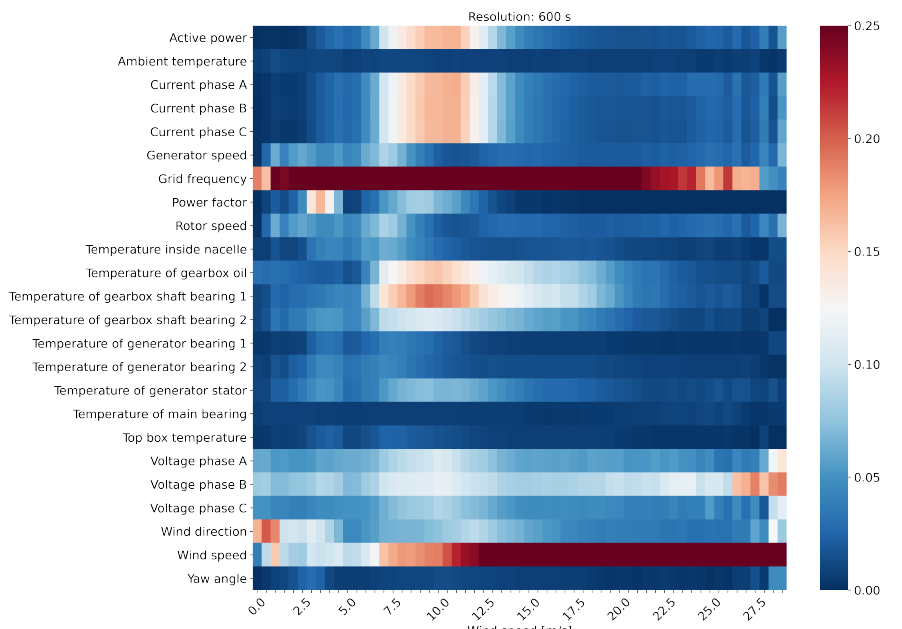
Figure 10. Heat map of the mean average of the aggregation error value per wind speed bin. Signals are normalized by the IQR and the color scale is capped to avoid grid frequency and wind speed to hide the behavior of the other